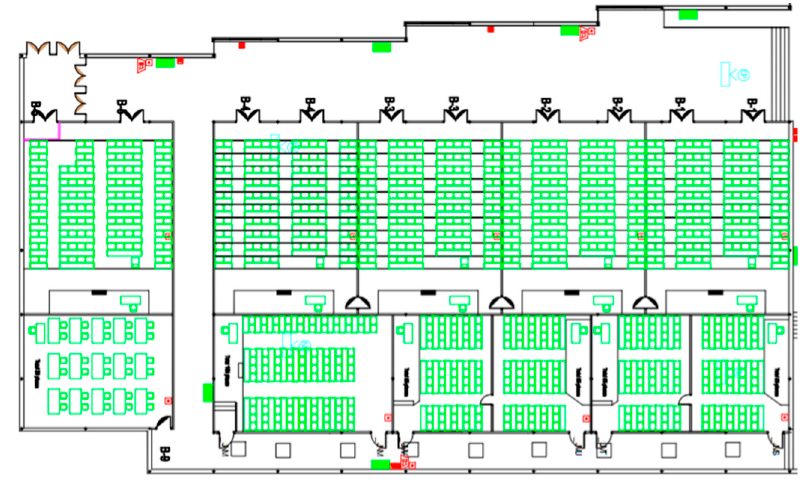
Figure 15. Simulated space.